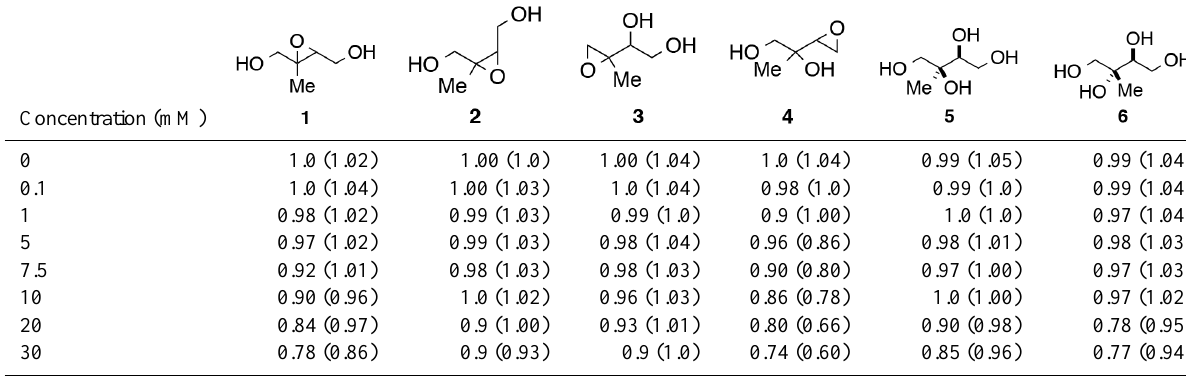
Table 2. Supersaturation ratios for IEPOX (1–4) and 2-methyltetraols (5, 6).